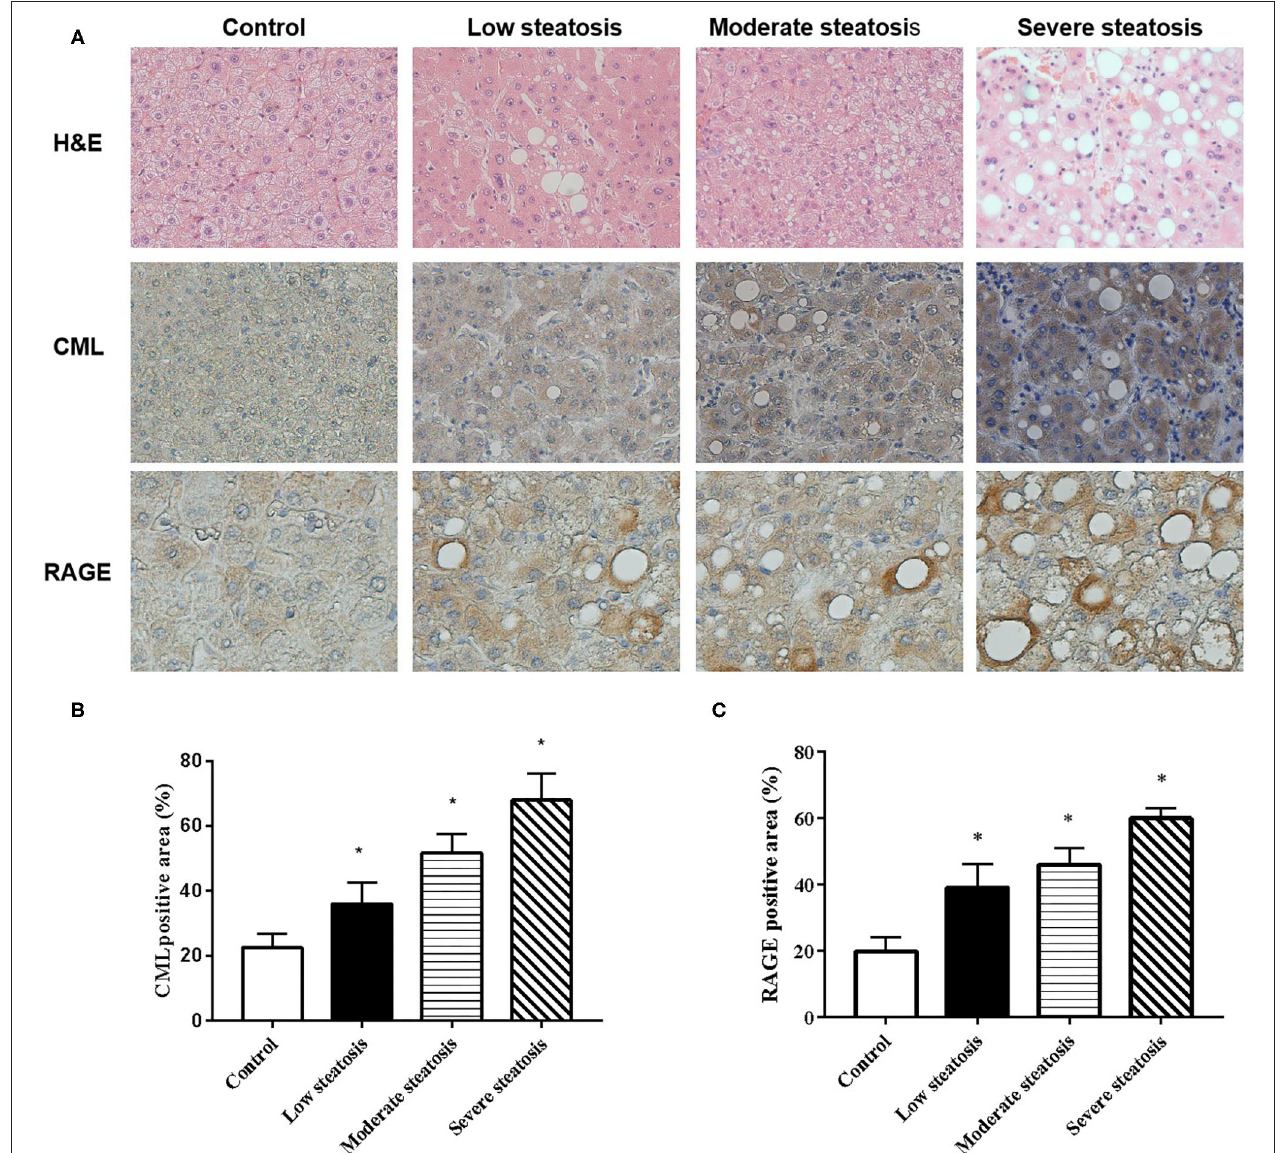
FIGURE 1 | CML accumulation in liver tissue of patients with non-alcoholic fatty liver (A) . First row: Liver biopsy H&E ( × 200). Second and third row: immunohistochemistry shows the expression of CML ( × 200) and RAGE ( × 400) (B) . Percentage of CML-positive immunohistochemical staining area (C) . Percentage of RAGE-positive immunohistochemical staining area. The proportion of the positive area to the total liver area was calculated by ImageJ. All data are expressed as the means ± SEM. * P < 0.05, compared to control group.